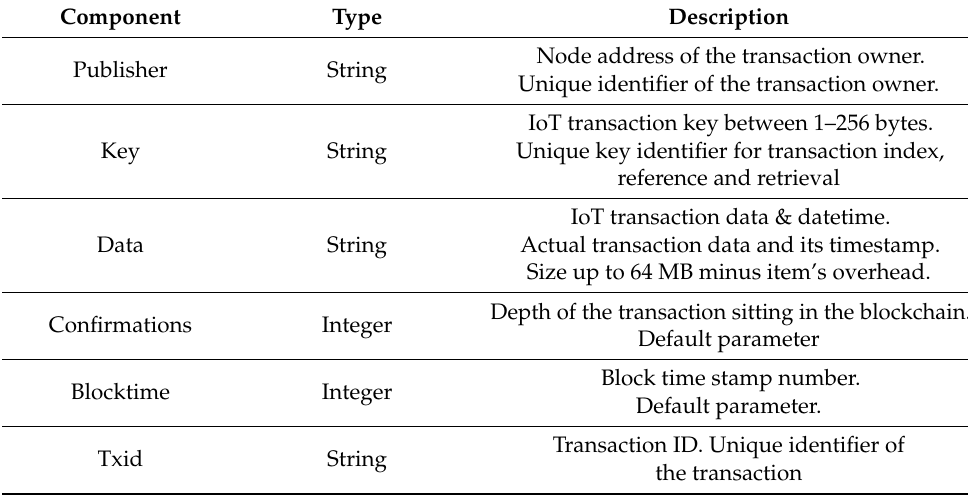
Table 5. IoT blockchain stream item